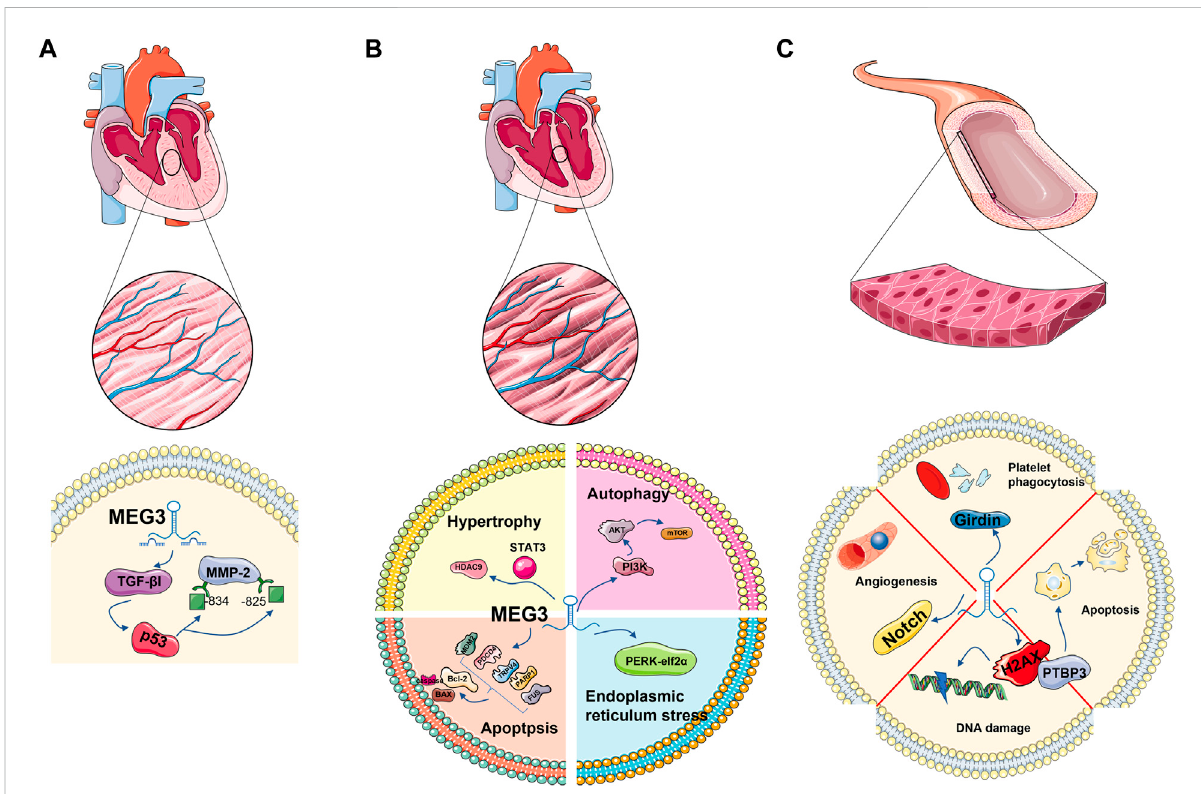
FIGURE 3 MEG3 plays a role in cardiovascular-related cell types: cardiomyocytes, cardiac fi broblasts and endothelial cells. Regulation of TGE- β 1 and P53 in cardiac fi broblasts; It is involved in apoptosis and autophagy in cardiomyocytes. It is associated with autophagy and DNA damage in endothelial